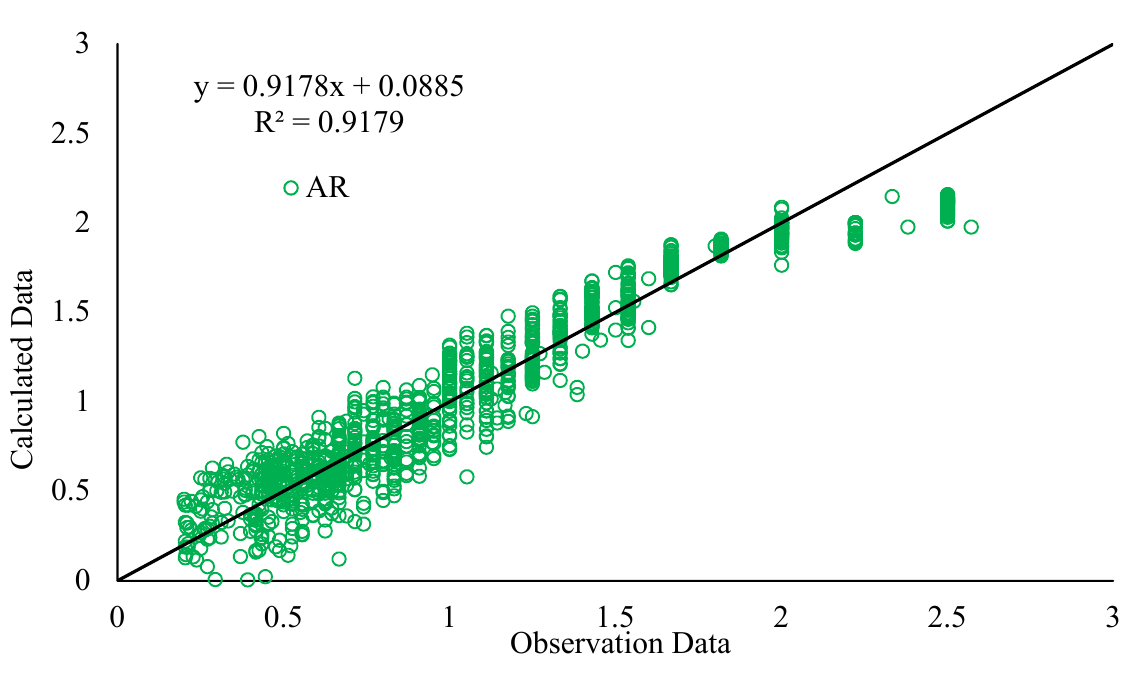
Figure 15. Predicted vs. experimental values of AR output for MLR model using all data.